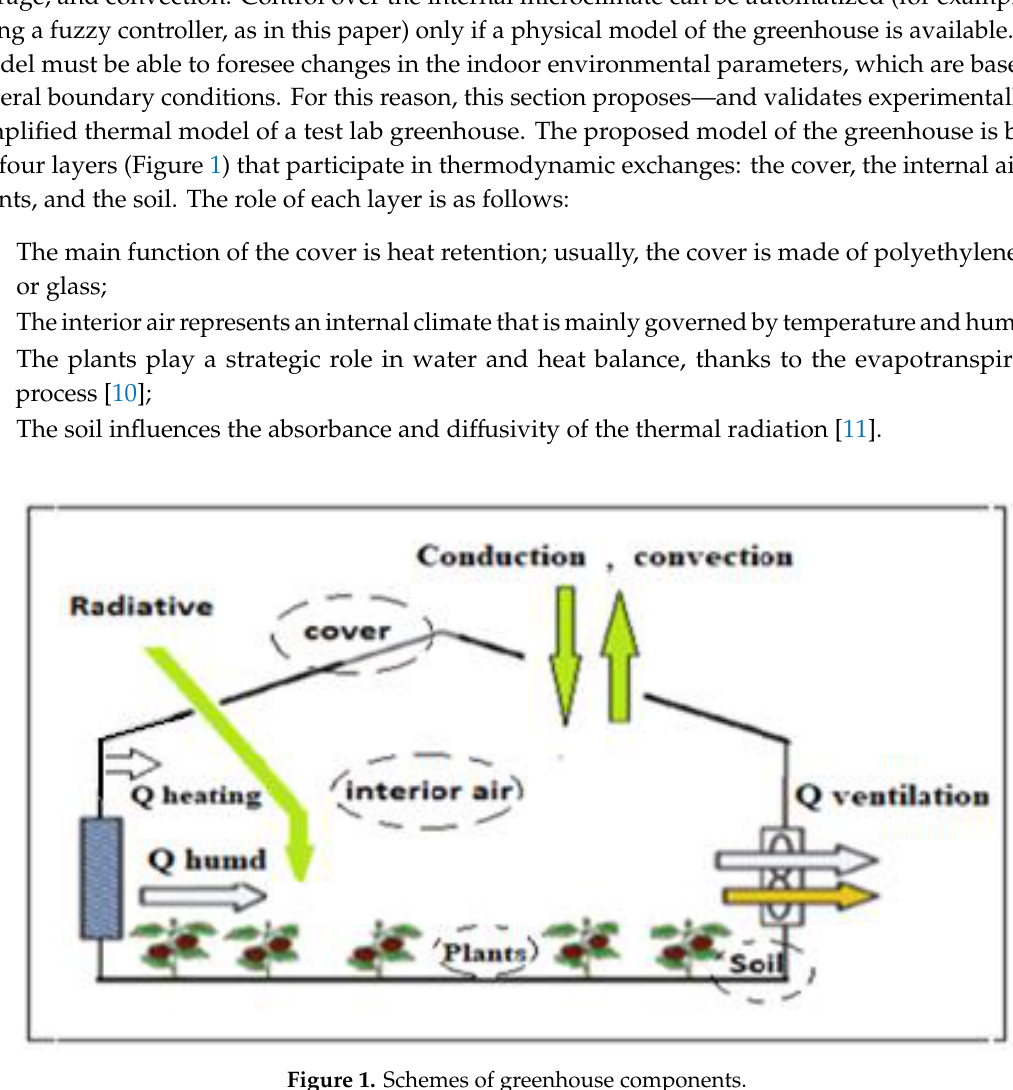
Figure 1. Schemes of greenhouse components.